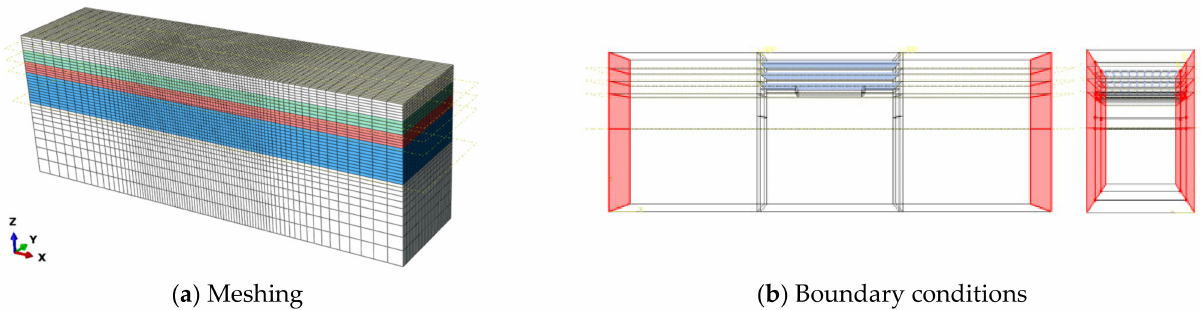
Figure 3. Meshing and boundary conditions’ setting.